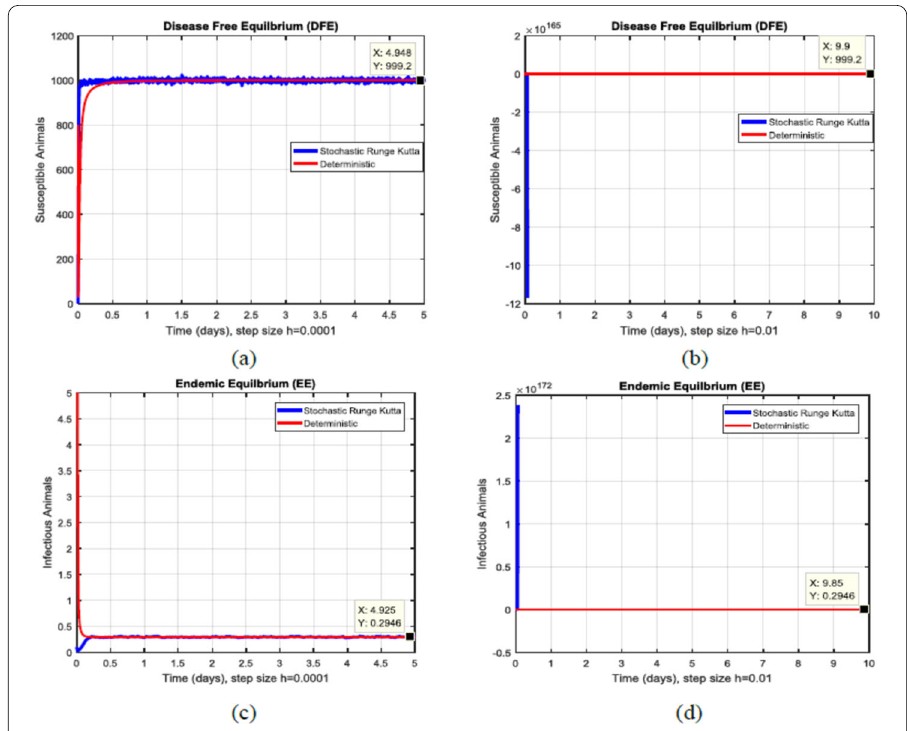
Figure 4 ( a ) Susceptible animals converge to disease free equilibria at h = 0.0001. ( b ) Susceptible animals diverge to disease free equilibria at h = 0.01. ( c ) Infectious animals converge to endemic equilibria at h = 0.0001. ( d ) Infectious animals diverge to endemic equilibria at h =